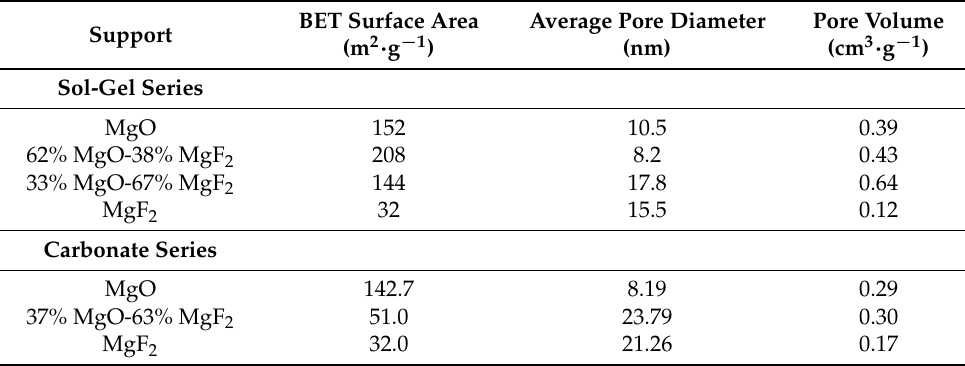
Table 1. Support characterization (adapted from